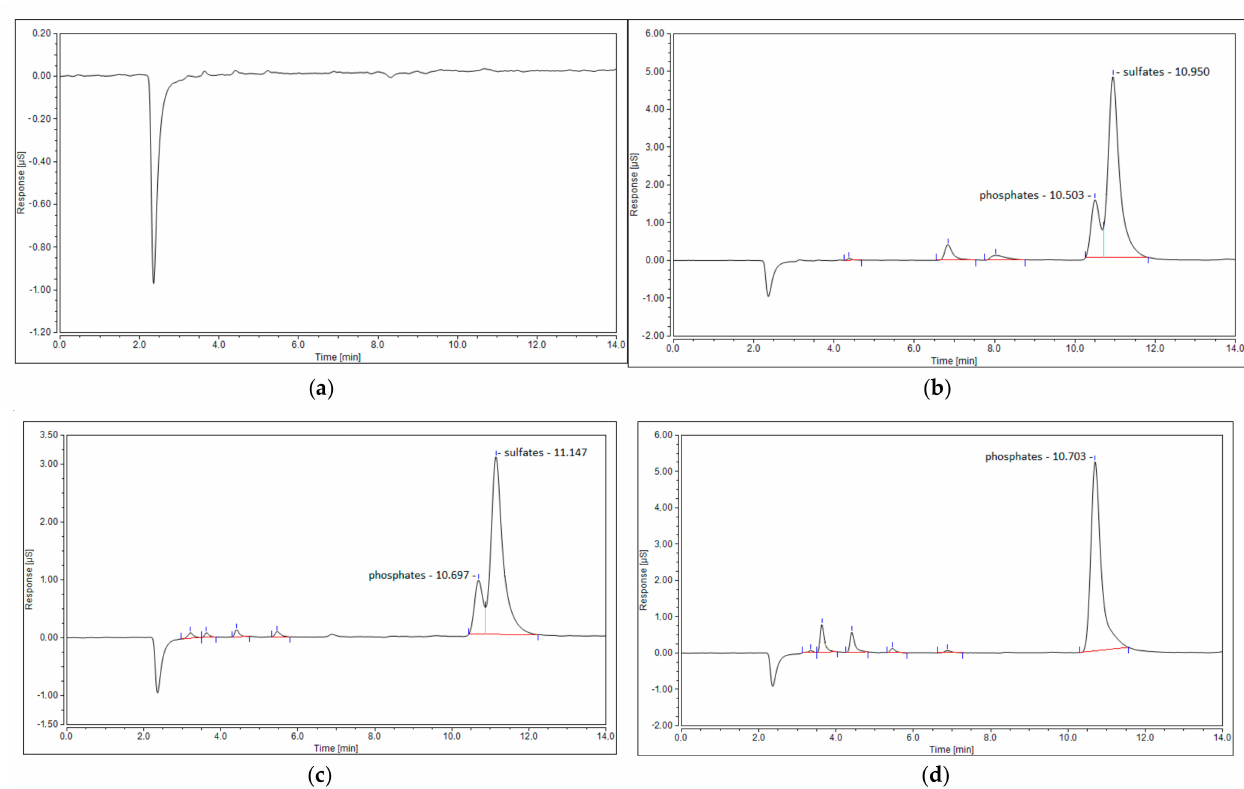
Figure 9. Ion chromatogram of four samples: ( a ) blank sample; ( b ) N 2 +CO 2 +H 2 S mixture; ( c ) simulated syngas—20 NLPM; and ( d ) simulated syngas—30